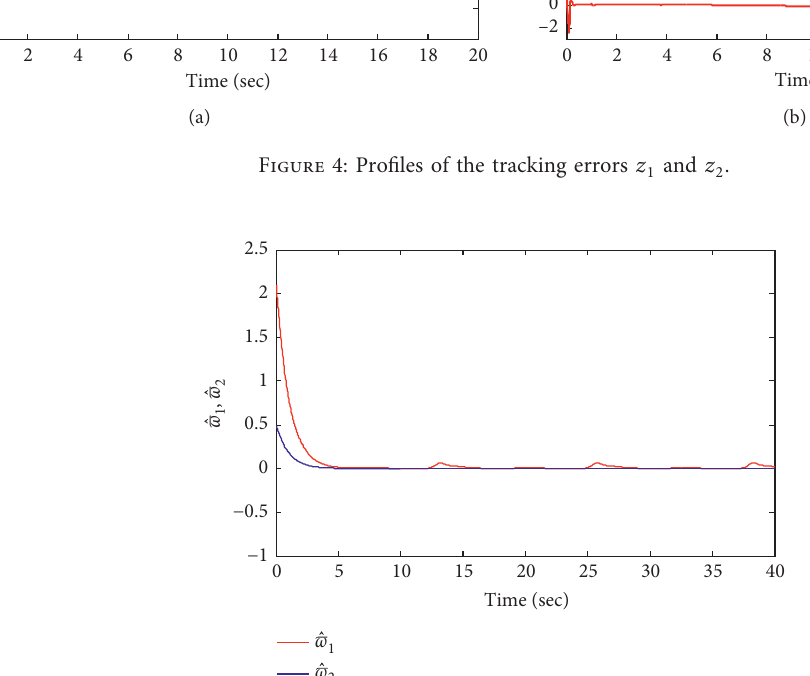
Figure 5: Estimated parameters 􏽢 ϖ